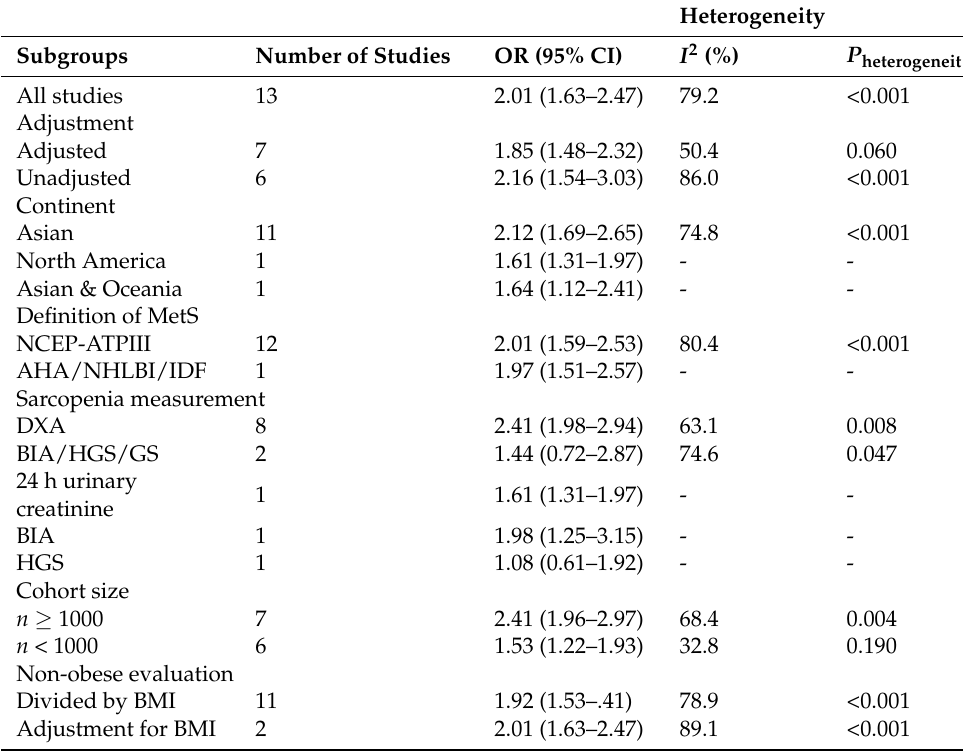
Table 3. Pooled ORs and 95% CIs of the associations between MetS and